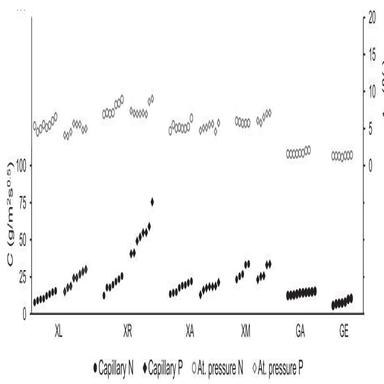
Water absorption results by specimen.